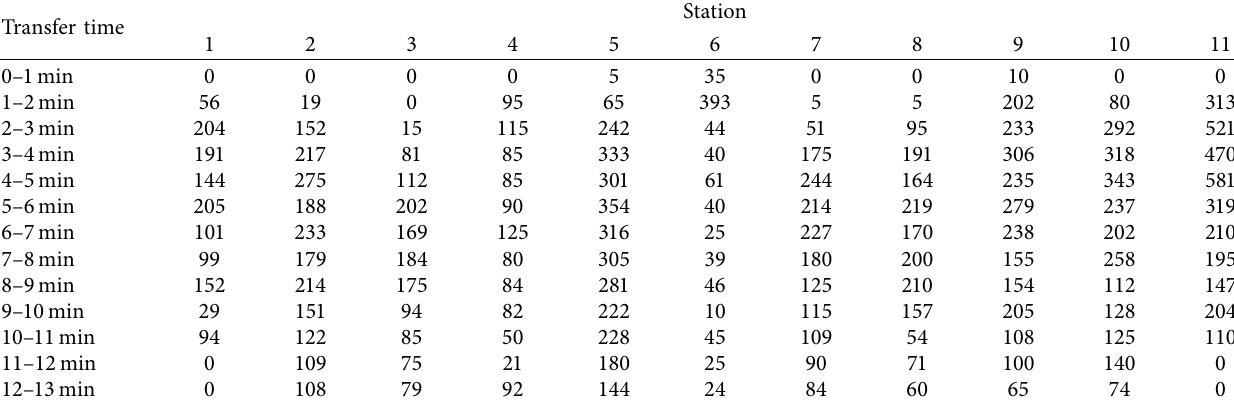
Table 3: The number of transfers of each station with group spacing of 1